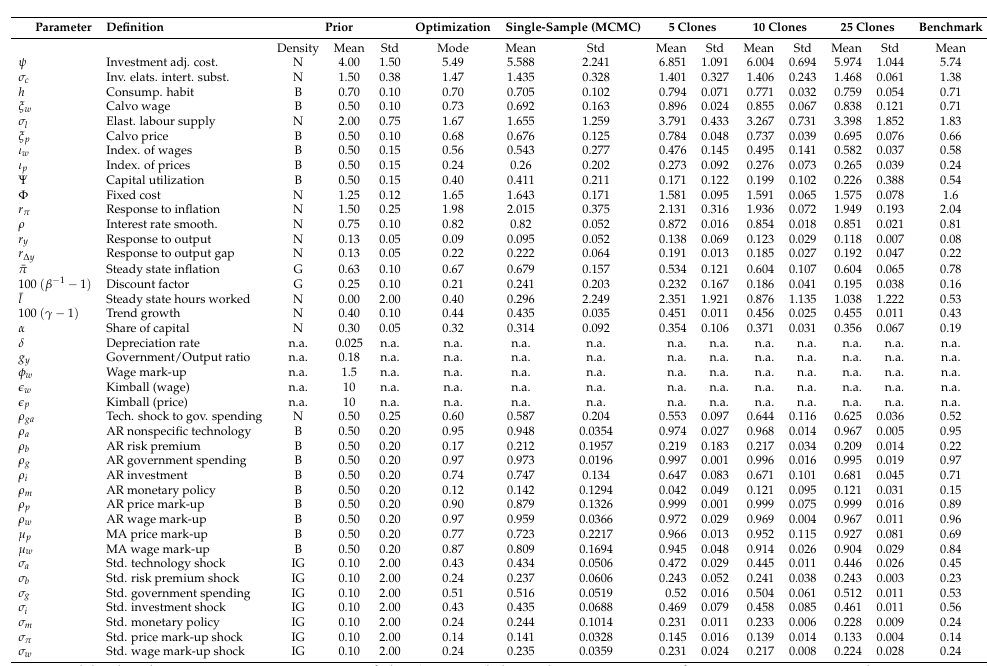
Table 1. Data cloning posterior estimates.